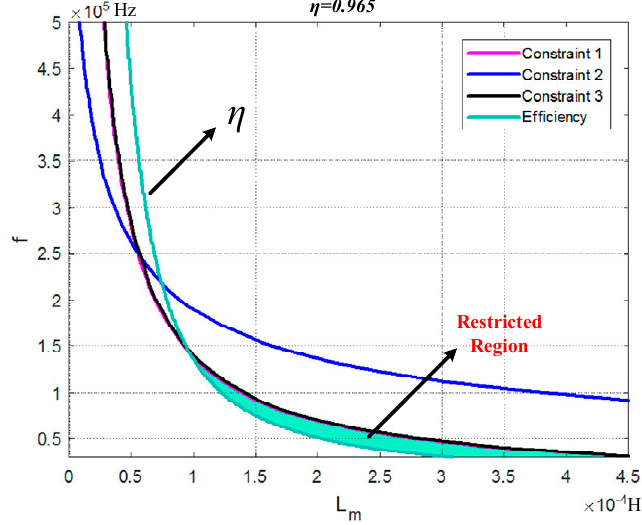
Figure 8. Intersection of ZVS constraints and efficiency requirement ( η > 96.5%).